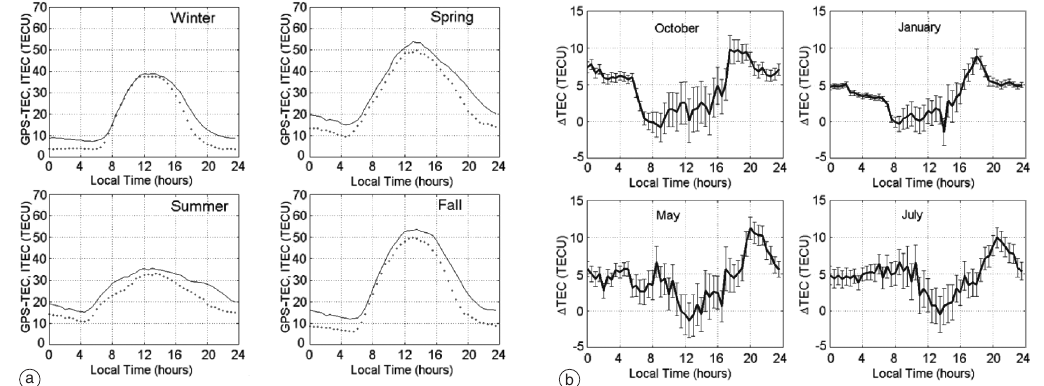
Fig. 3.17a,b. A seasonal comparison of GPS-TEC and ITEC, as observed at Athens during the period October 2000 to September 2001. a) The diurnal variation of GPS-TEC (solid lines) and ITEC (dotted lines) for the four seasons extracted from the mean of the monthly median values; b) the daily variation of the monthly median val- ues of ∆ TEC over four